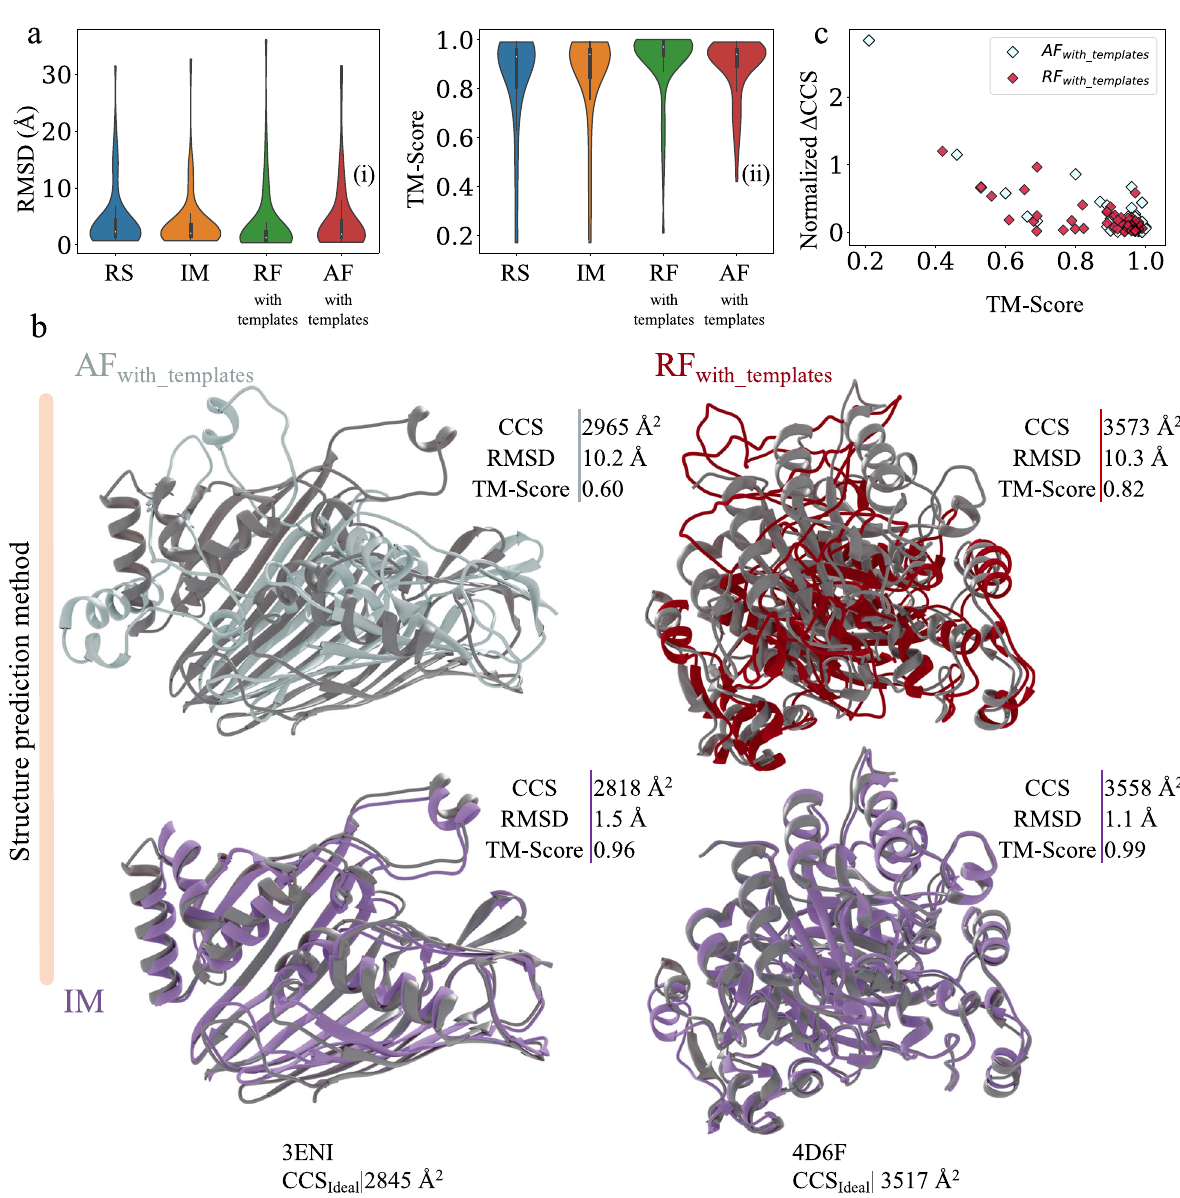
Fig. 3 | Comparison ofpredictions with ideal ion mobility (IM) data to those of AlphaFold (AF) and RF (RosettaFold). Predictions, for the ideal dataset, using theIMscorefunctionwerecomparedtothatofRosetta(RS),AF with_templates ,and RF with_templates . a Violin distributions ( n = 60 biologically independent samples over 4 independent modelling approaches), of (i) root mean square deviation (RMSD)and (ii)templatemodelling score(TM-Score)of the predicted structure using the RS, IM, AF with_templates and RF with_templates score functions. For protein structure predictions with methods shown in a the mean and the standard error of mean in (i) are 4.46 ± 0.74Å, 3.72 ± 0.65Å, 3.43 ± 0.77Å, and 4.37 ± 0.80Å respectively. Similarlythe mean and the standard error of meanin (ii) are0.84± 0.03, 0.86 ± 0.02, 0.92 ± 0.02, and 0.88 ± 0.02 respectively. For the violin